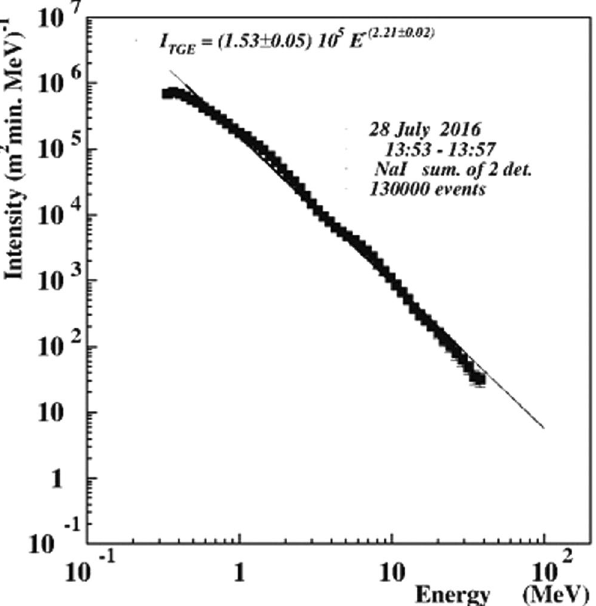
Figure 4. Energy spectrum of TGE exteneded up to 30 MeV measured by 2 NaI spectrometers during 4 minutes of